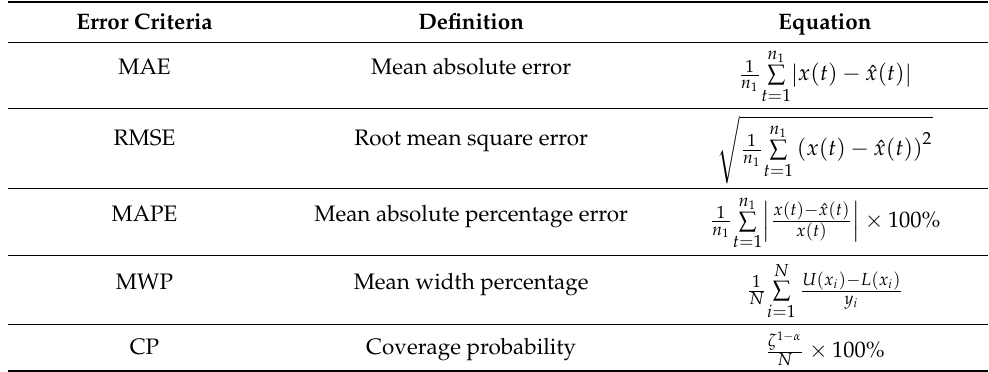
Table 1. The statistical measurements used in the prediction results.